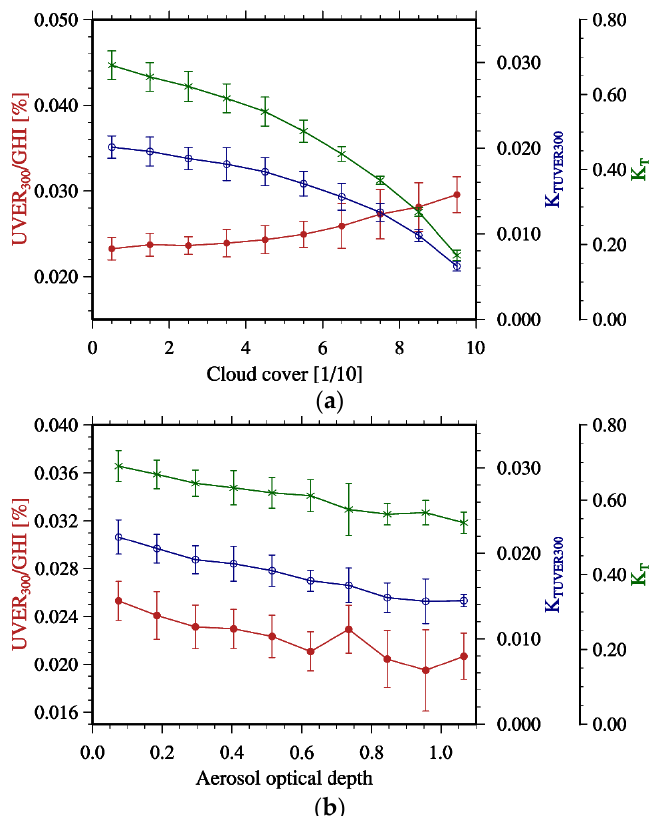
Figure 6. Dependence of UVER 300 /G (red filled circle) and two clearness indices, K T (green asterisk) and K TUVER300 (blue open circle), on ( a ) cloud cover and ( b ) aerosol optical depth.